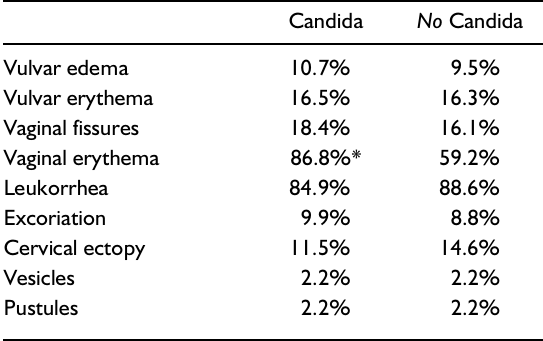
Table 5 Clinical findings in women with vulvovaginitis and positive or negative for Candida by